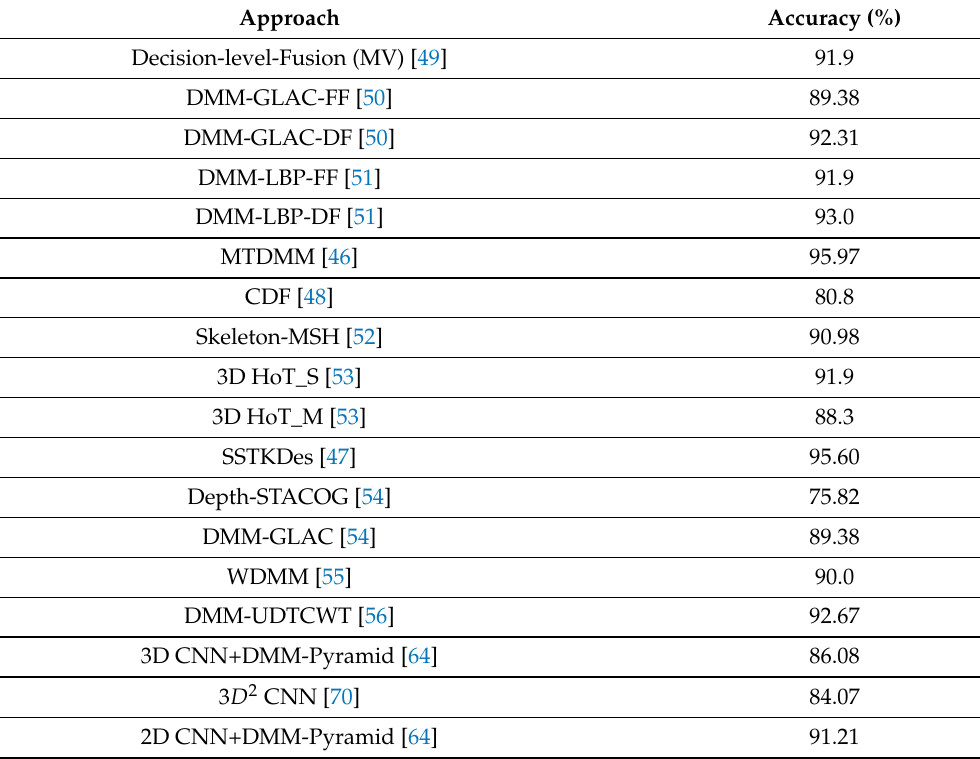
Table 1. Comparison of action recognition accuracy (%) with state-of-the-art frameworks on the MSRAction3D test